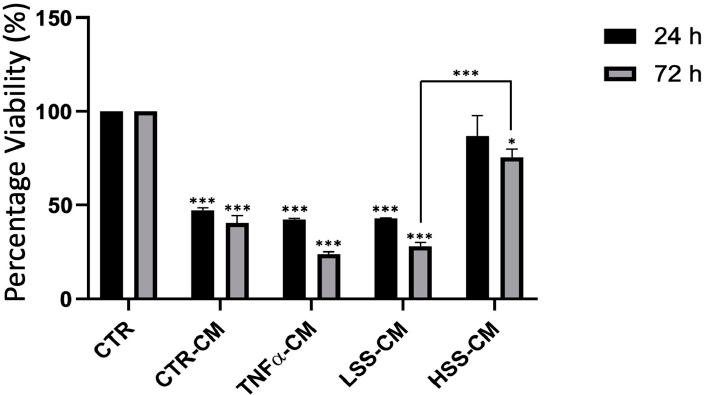
Figure 6. MTT assay on HUVECs subjected to control (CTR), TNF α - and LSS-conditioned medium (CM) for 24 and 72 h. (* p < 0.05; *** p < 0.005).